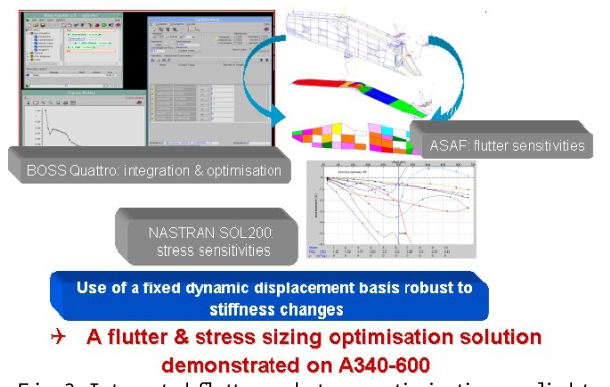
Fig. 3. Integrated flutter and stress optimization applied to A340-600 engine pylons